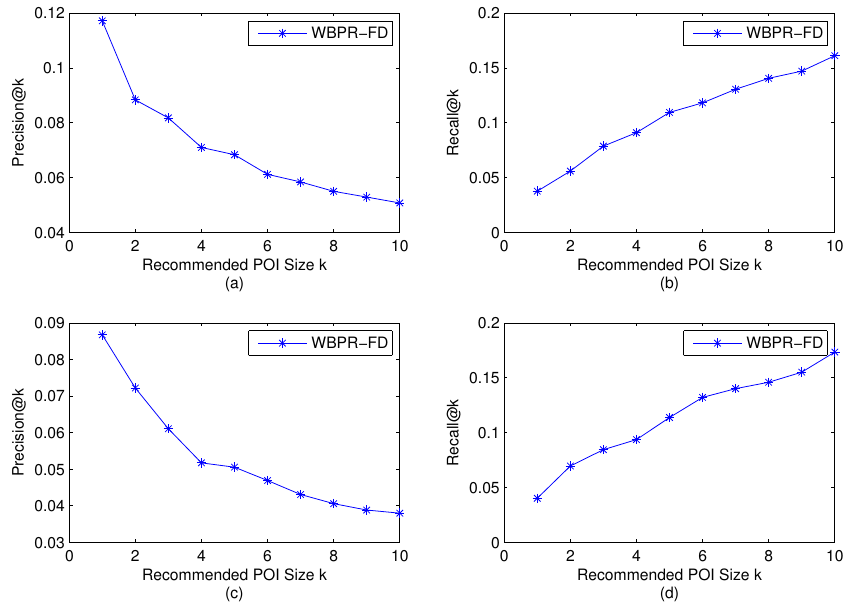
Figure 9. Impact of recommended POI size in the Gowalla and Brightkite data. ( a ) Precision @ k in Gowalla. ( b ) Recall @ k in Gowalla. ( c ) Precision @ k in Brightkite. ( d ) Recall @ k in